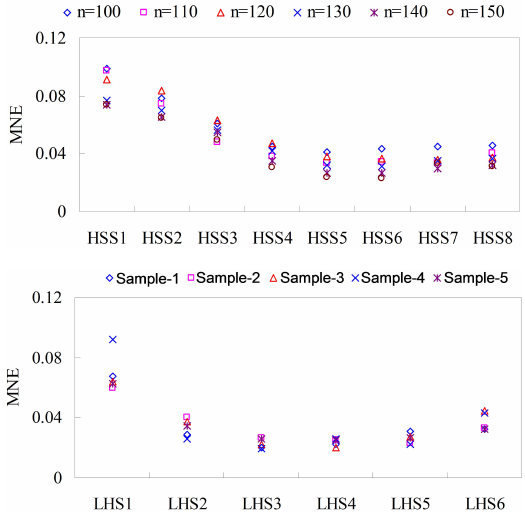
Fig. 6. Sensitivity of prediction performances to marginal level through computational experiments. (a) Quasi-HSS-4vs2 (4 types of NO x with 2 types of VOC sources, 100–160 samples); (b) quasi- LHS-4vs2 (4 types of NO x with 2 types of VOC sources, 160